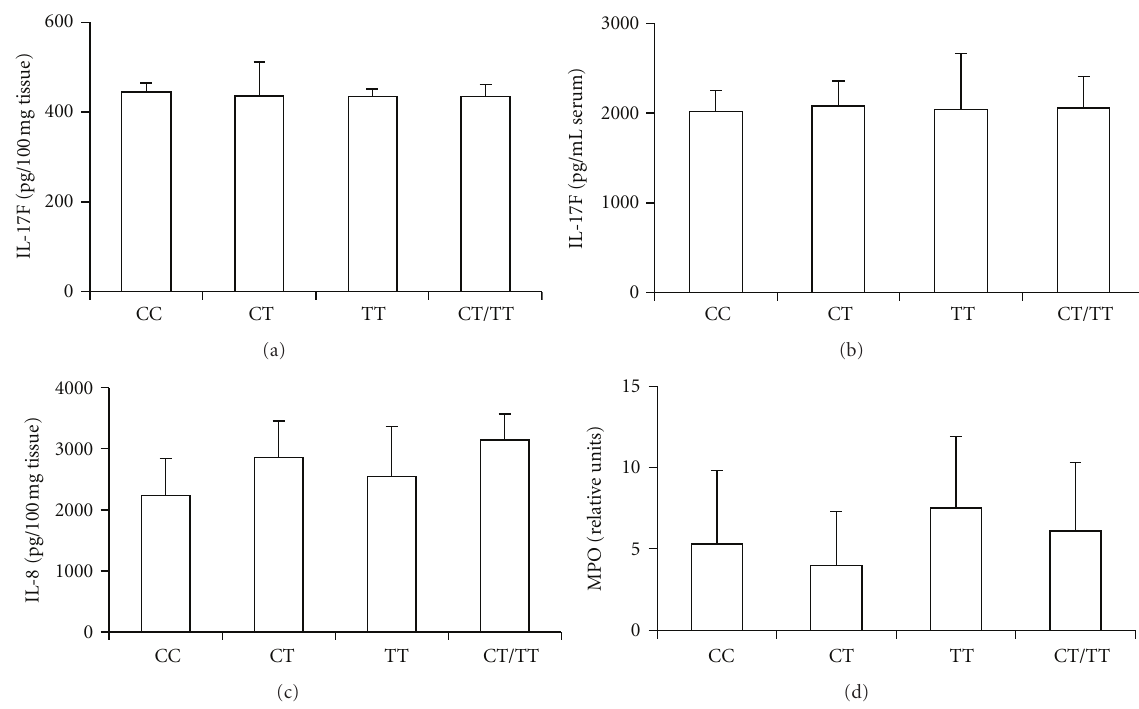
Figure 3: Levels of inflammatory mediators in chronic periodontitis patients according to each IL-17F C7488T genotype. (a) Levels of IL-17F in gingival tissues and (b) serum. (c) Levels of IL-8 and (d) MPO (myeloperoxidase) activity in gingival tissue